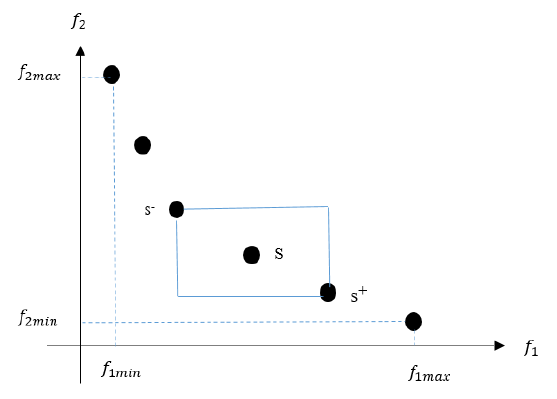
Figure 3. Crowding-distance.